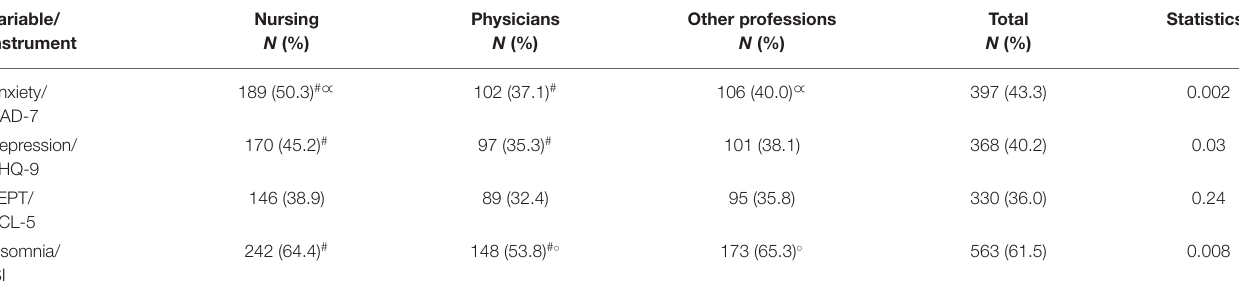
TABLE 2 | Indicators of mental health problems, considering the cut-off point of each instrument for the three groups of workers. Variable/